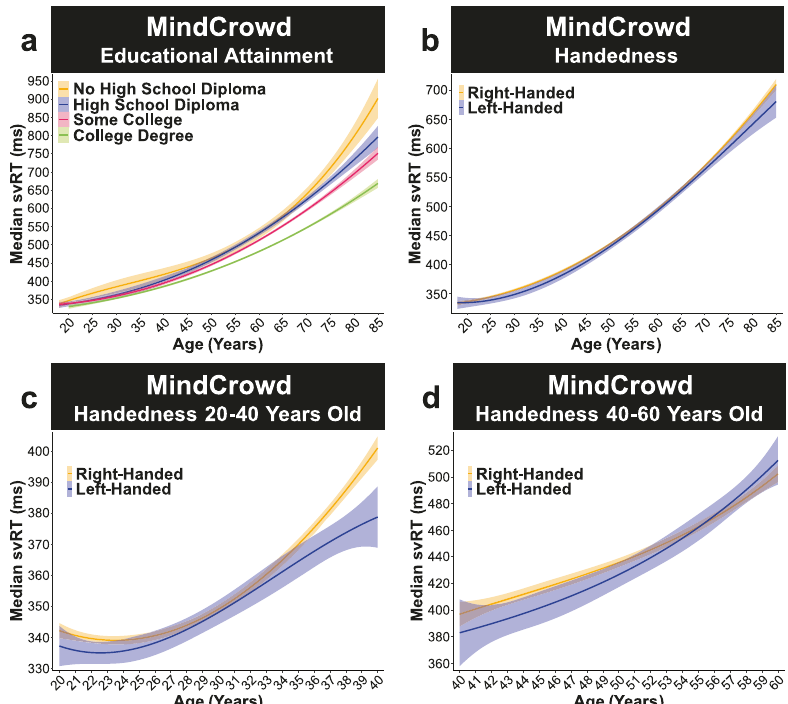
Fig. 2 MindCrowd: educational attainment and handedness. MindCrowd analysis (ages 18 – 85) of simple visual reaction time (svRT). a Linear model fi ts (line fi ll ±95% CI) of the median svRT by Age 3 (curvilinear model) with lines split by Educational Attainment. Participants who had “ Some College ” ( β College = − 14.73, p College = 8.74E − 05, n = 22,950), or a “ College Degree ” ( β CDegree = − 31.78, p CDegree = 2.95E − 17, n = 44,140) were shorter than those with “ No High School Diploma ” ( n = 1881). b – d Linear model fi ts (line fi ll ±95% CI) of the median svRT by Age 3 (curvilinear model) with lines split by Handedness. b From 18 – 85 years old, left-handed participants showed slightly shorter svRTs ( β Left = − 3.87, p Left < 0.03), ( c ) an association found in 20 – 40 years old ( β 40Left = − 3.16, p 40Left < 0.01, Left-Handed n = 8,449), ( d ) but not 40 – 60 years old ( β 60Left = − 2.69, p 60Left = 0.07, Right-Handed n =